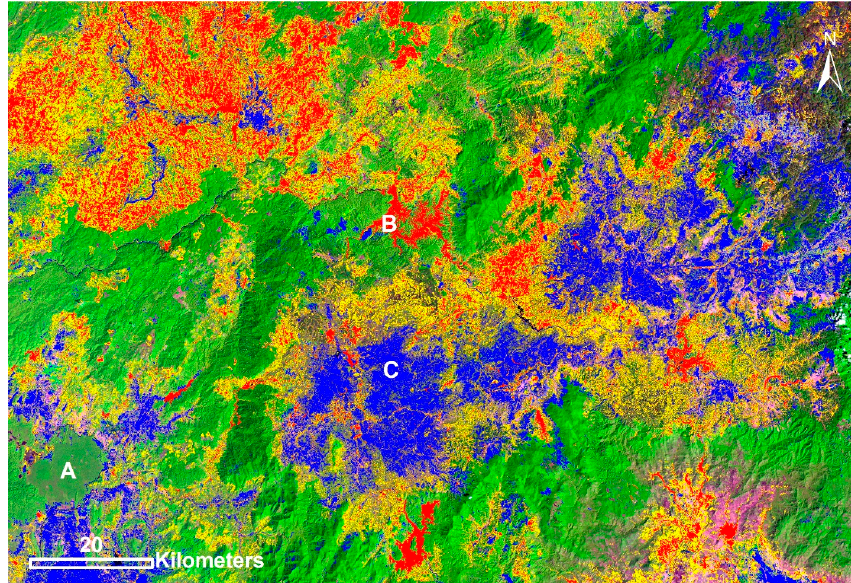
Figure 7. Normalized Difference Vegetation Index (NDVI) trend image based on regression analysis generated using 1985–2014 time series data. Red indicates where NDVI shows major decrease in greenness, whereas yellow shows moderate decrease in greenness. Blue indicates where greenness increased. A = Mature forest (no increases or decreases in NDVI) associated with Cat Tien National Park. B = Area transformed from forest to reservoir. C = Area of greening related to agroforestry.